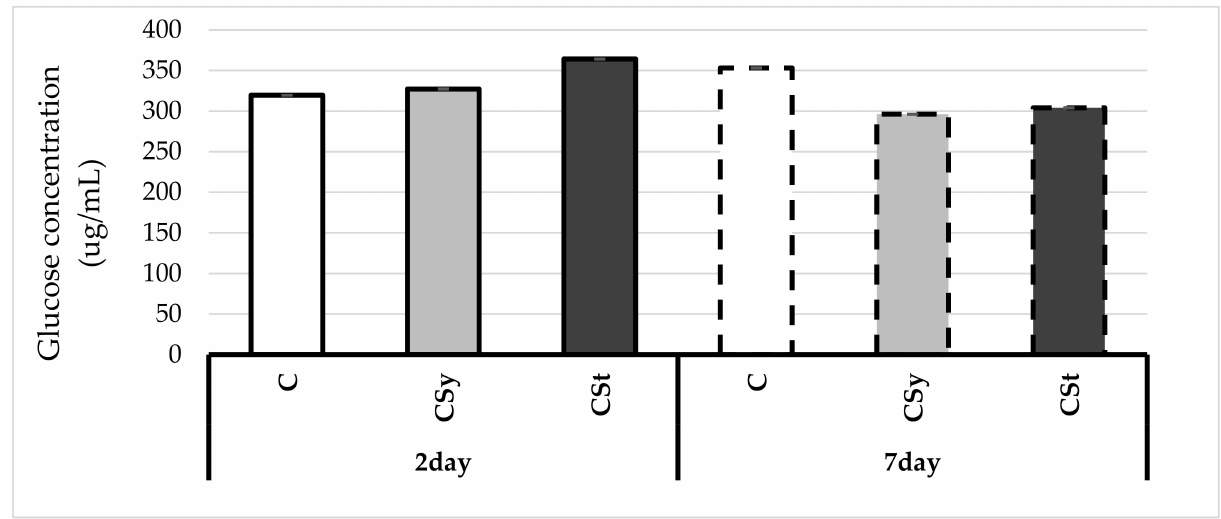
Figure 5. Glucose concentrations in the 2- and 7-day-old workers’ hemolymph after two methods of supplementation with hemp extract: C–control (pure sugar syrup), Csy–hemp extract in syrup, Cst–hemp extract on strips. (Two-Way ANOVA: supplementation method: F (2,59) = 494.15, p = 0.000; days of supplementation: F (1,59) = 748.37, p = 0.000; supplementation method*days of supplementation F (2,59) = 1639.0, p =